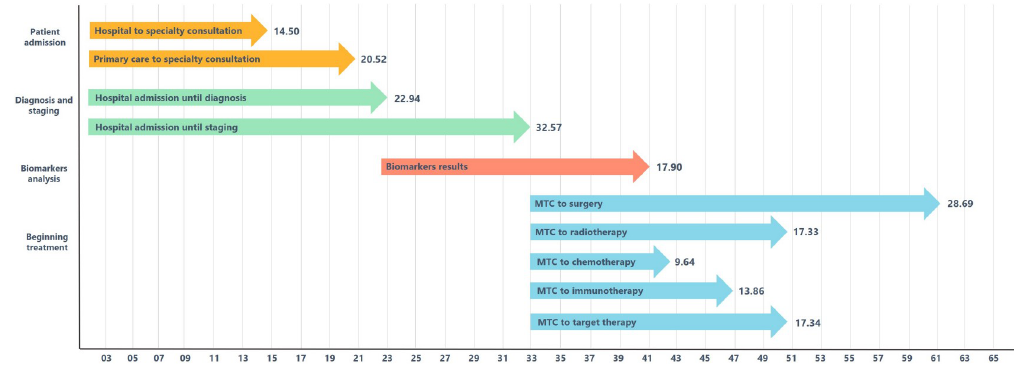
Fig 1. Summary of the main stages and median lag times (days) for lung cancer diagnosis in Portugal (MTC: Multidisciplinary consultation). https://doi.org/10.1371/journal.pone.0252529.g001 lag time from patients’ first admission until beginning of therapy varied from around 42 days (6 weeks) for chemotherapy to around 50 days (7 weeks) for radiotherapy or target therapy, until around 61 days for surgery (almost 9 week) (see Fig 1). Professionals working at private hospitals also reported a lower median time from multidis- ciplinary consultation to the beginning of both surgery, radiotherapy and immunotherapy when compared to those from public hospitals (p < 0.001, p = 0.004 and p = 0.003, respec- tively). According to the expert’s perception, time for diagnosis can be optimized in all steps of the process (diagnosis, disease staging and beginning of therapy) in around 10–15 days. Physi- cians that treat only lung cancer patients stated that time for diagnosis can be reduced in 8.75 days (95% CI 6.40–11.10) while the overall sample answered a median time of 11.05 days (95% CI 9.61–12.50) (p = 0.010). Responders working at public hospitals believe that diagnosis can